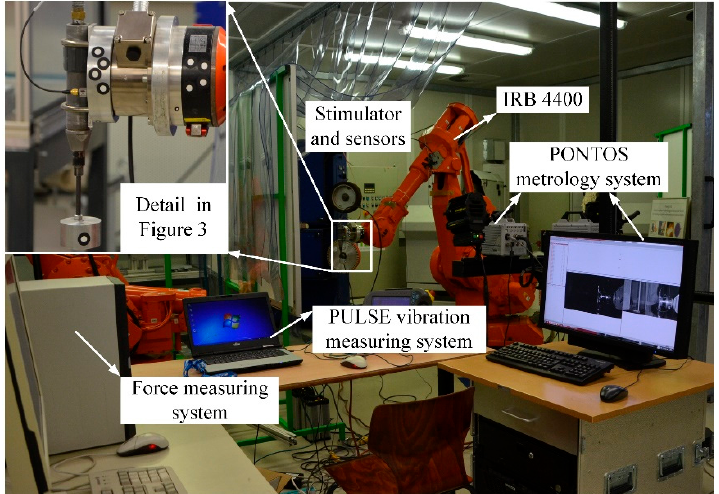
Figure 2. Configuration of vibration experiment setup.